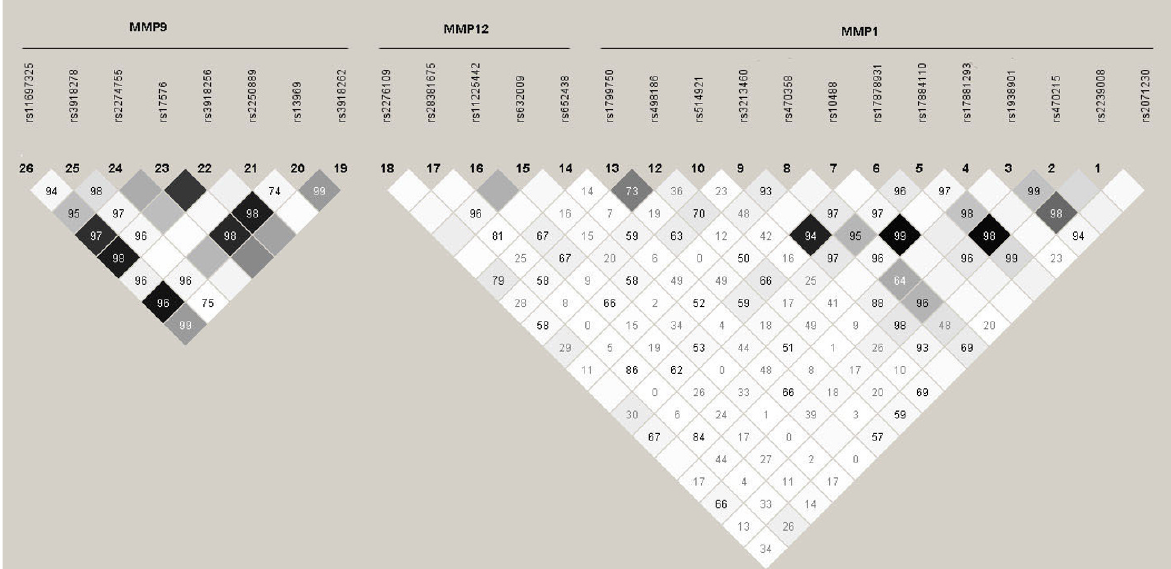
Figure 1 LD plot in controls of SNPs in MMPs- 1, 9 and 12 . Estimated as r 2 using Haploview 4.1 output. SNP codes are provided in order of location along each gene; dark grey squares depict strong LD (1.0) with strong confidence, pale grey and white regions represent low LD, and the r 2 value is provided within each box. SNP positions are demonstrated 5 ’ to 3 ’ relative to contig postion (HuRef NCBI build 36.3).